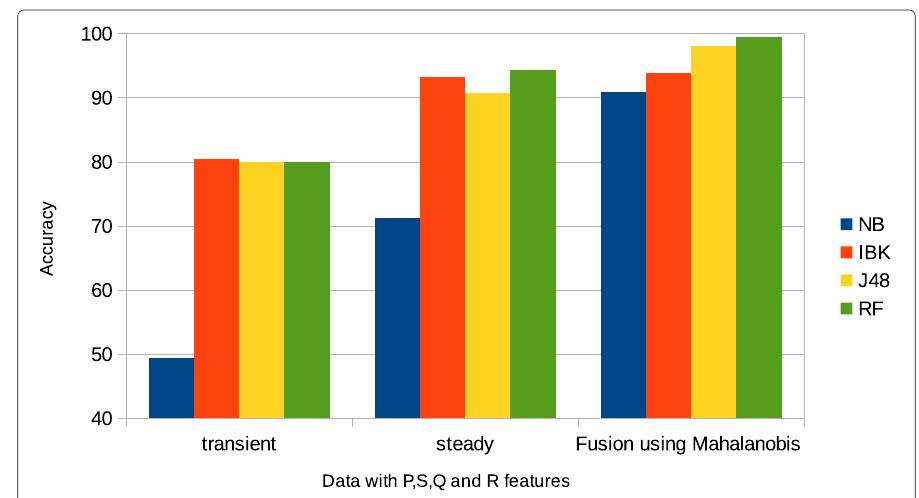
Fig. 7 Comparing Performance of fusion based NILM approach using P, S, Q and R feature data